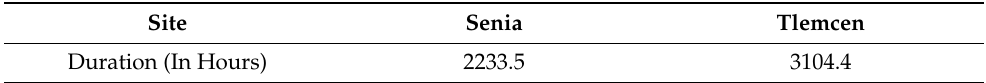
Table 5. Annual sunshine